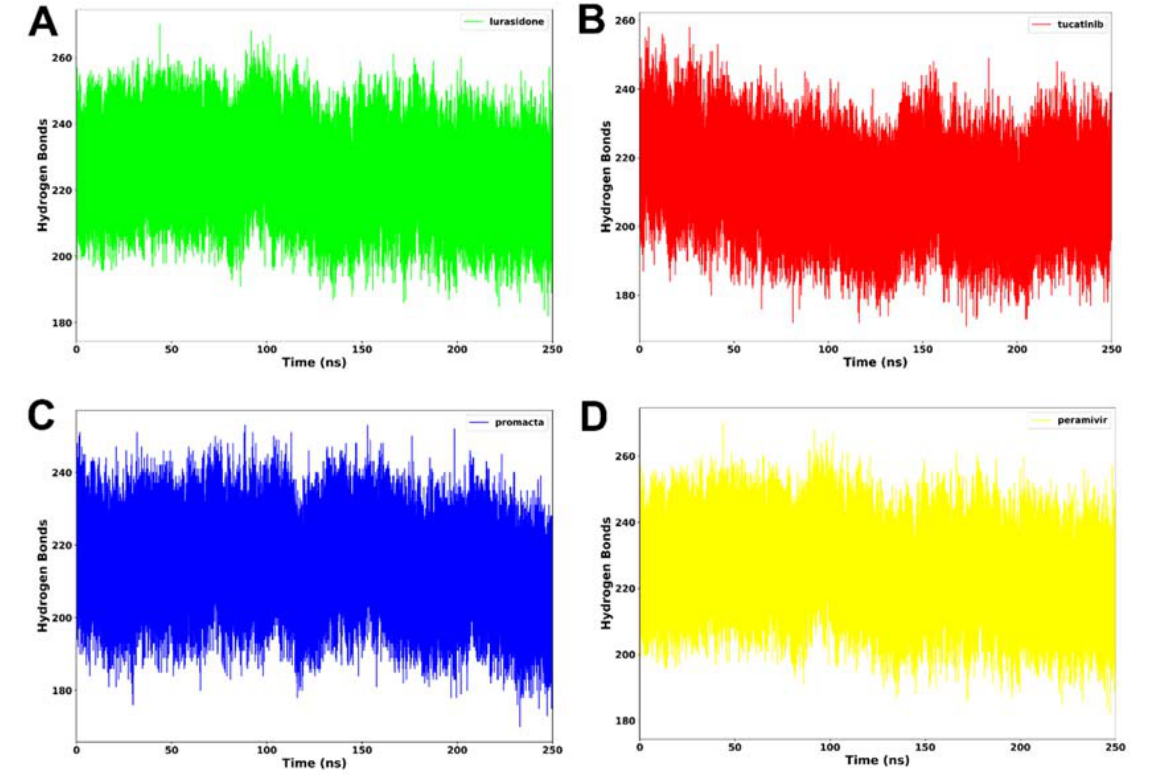
Figure 7. Hydrogen bond formation of NA complexed with lurasidone ( A ), tucatinib ( B ), Promacta ( C ), and peramivir ( D ) during 250 ns simulations.